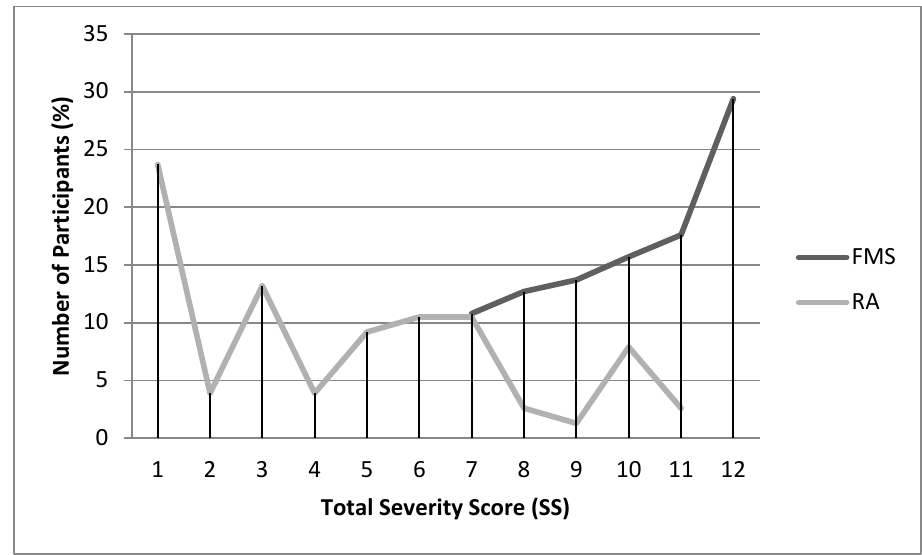
Figure 2. Distribution of Total Symptoms Severity (SS) scores in FMS and RA patients.